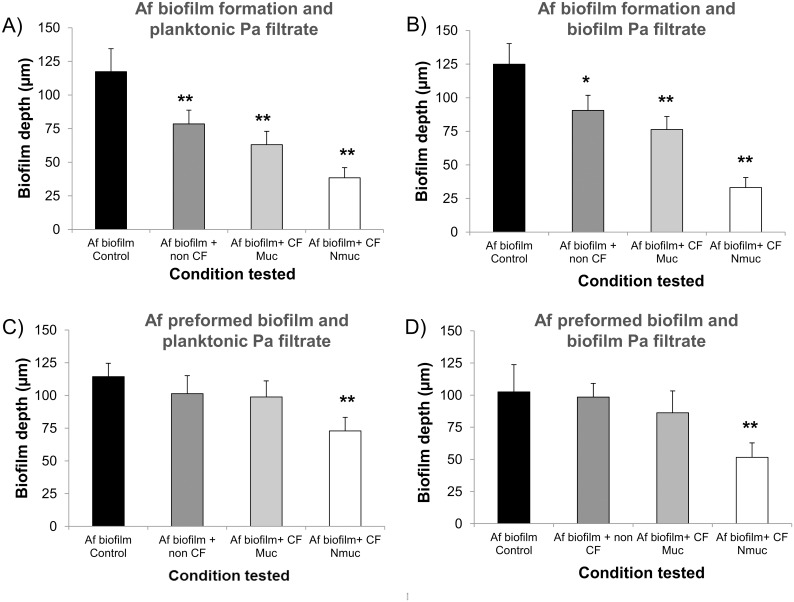

Pa supernatant affects Af biofilm thickness.
Af biofilms were formed and stained as described. Sections of the xy plane were taken at 1 μm intervals along the z-axis to determine the depth of the biofilms. (A) Af conidia were exposed to planktonic Pa spent supernatant or (B) biofilm Pa spent supernatant, for 16 h. (C) Af preformed biofilms were exposed to planktonic Pa spent supernatant or (D) biofilm Pa spent supernatant, for 24 h. Assays were performed in triplicate and images were taken from three different fields from each sample. The results are representatives of two different experiments for each Pa-Af combination. One asterisk indicates a P value (<0.01), and two asterisks indicates a P value (<0.001) for the biofilm thickness compared to the untreated control.